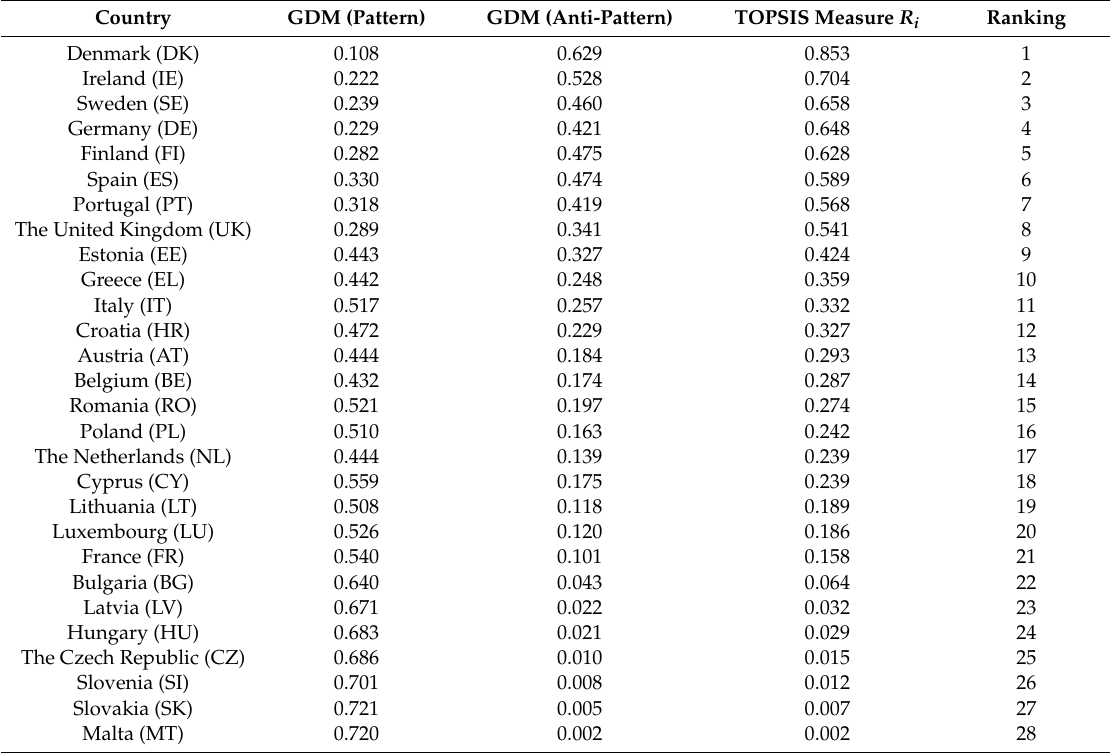
Source: own elaboration based on the data